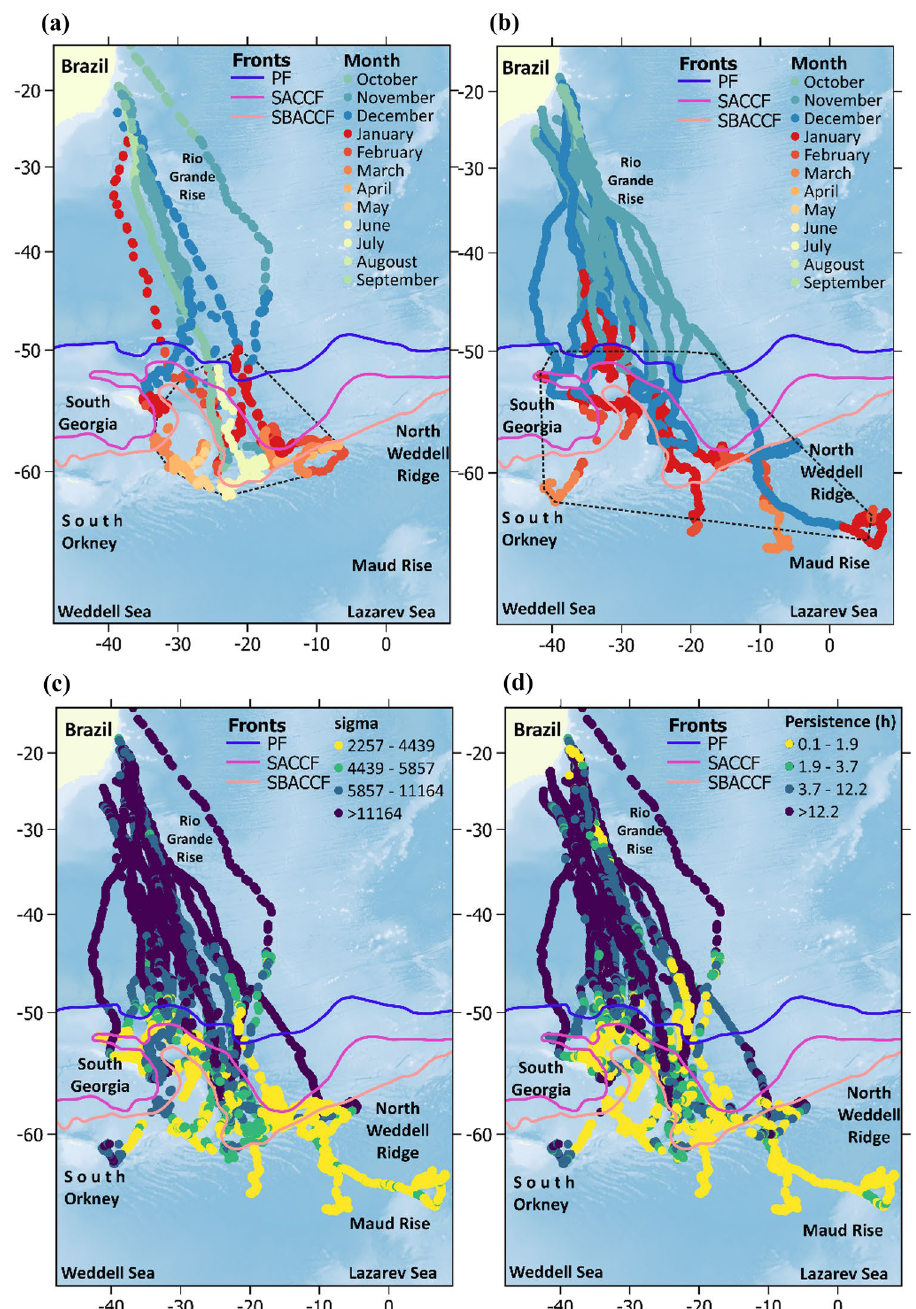
Figure 1. Locations are color coded by month for the first ( a ) and the second ( b ) tagging period. Polygons delimited by black dotted lines indicate the minimum convex polygon for 95% locations south of 50°S. Estimated change in ( c ) sigma (σ t ) and ( d ) persistence ( p t = 3/β t ) for humpback whales based on I-models. Colored lines denote the location of polar front (PF), Southern Antarctic Circumpolar Current Front (SACCF), and the southern boundary of the Antarctic circumpolar current (SBACCF). Antarctic circumpolar fronts data is made publicly available by the Australian Antarctic Data Centre (https:// resea rchda ta. edu. au). Data layers (including maps) were created in R ver. 4.0.2 (www.r- proje ct. org) and ensembled in QGIS ver. 3.8.0 (www. qgis. org) for final rendering. Maps were created using data on bedrock topography from the National Centers for Environmental Information (https:// maps. ngdc. noaa. gov/ viewe rs/ grid- extra ct/ index. html). Grid-cells with values above 0 were considered land coverage and assigned a uniform